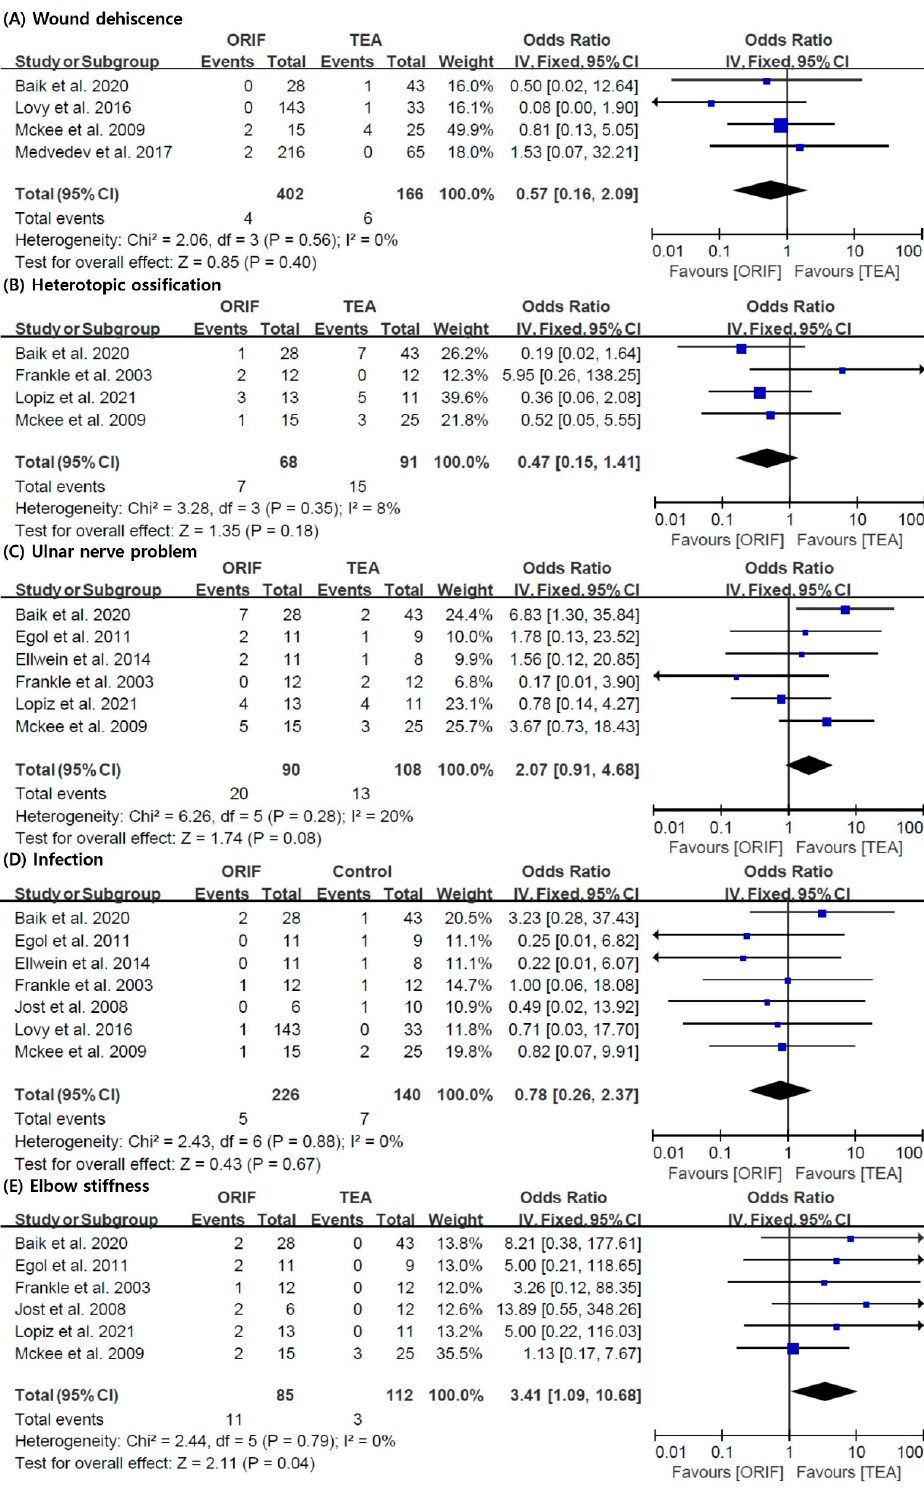
Figure 5. Results of the meta-analysis with respect to each complication: ( A ) wound dehiscence, ( B ) heterotopic ossification, ( C ) ulnar nerve problem, ( D ) infection, and ( E ) elbow stiffness [5,10,21,24–29]. ORIF: open reduction and internal fixation; TEA: total elbow arthroplasty.